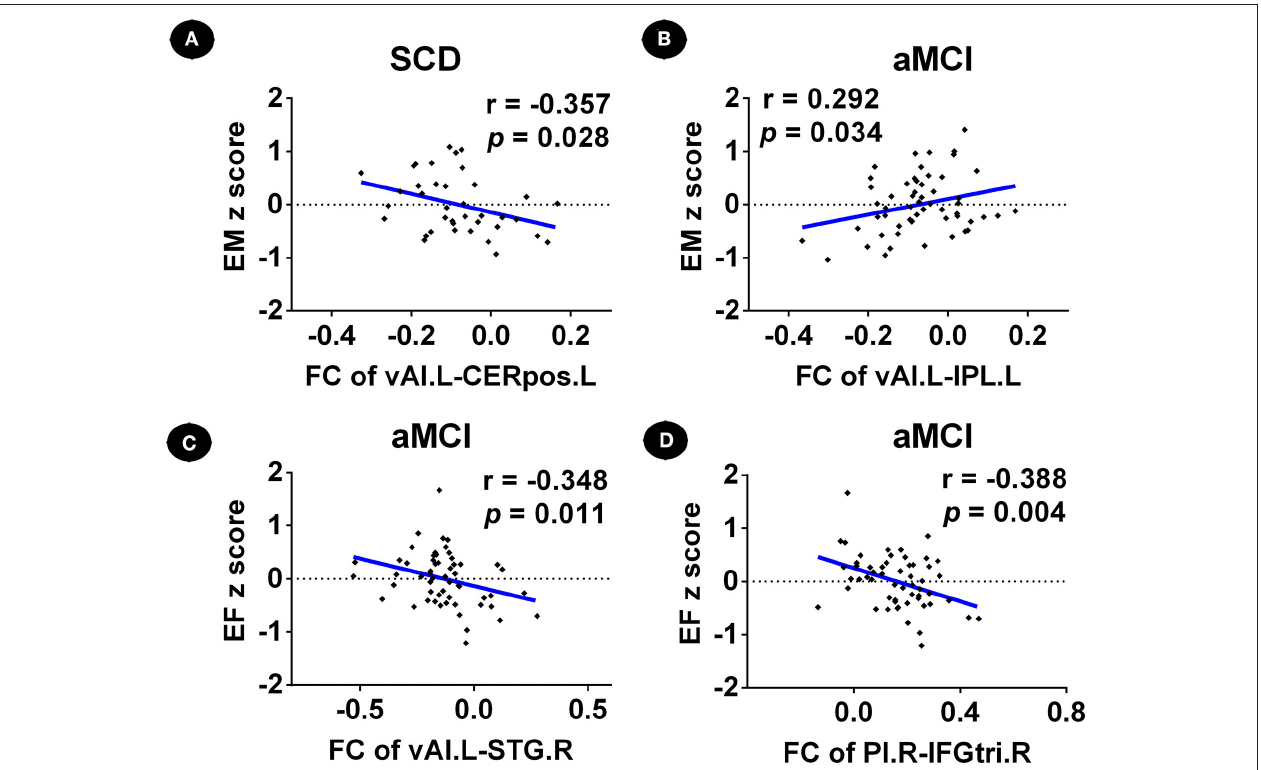
FIGURE 4 | Relationship between abnormal insular subnetwork functional connectivity and cognition in patients with SCD and aMCI. (A) Relationship between the insular subnetwork FC and cognition in patients with SCD. (B–D) Relationship between the insular subnetwork FC and cognition in patients with aMCI. FC, functional connectivity; CN, normal control; SCD, subjective cognitive decline; aMCI, amnestic mild cognitive impairment; vAI.L, left ventral anterior insula; PI.R, right posterior insula; CERpos.L, left cerebellum posterior lobe; IPL.L, left inferior parietal lobule; STG.R, right superior temporal gyrus; IFGtri.R, right inferior frontal gyrus, triangular part; EM, episodic memory; EF, executive